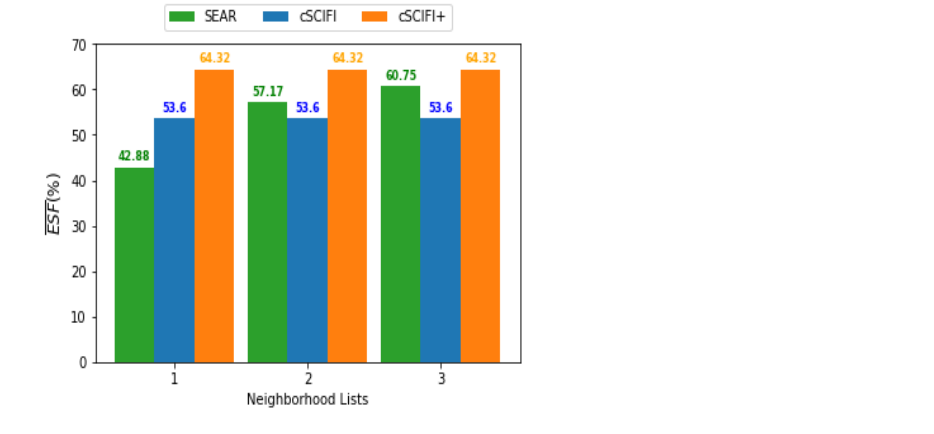
Figure 9. Normalized Energy saving factor comparison between SEAR and eSCIFI using both clustering algorithm with different neighborhood lists.